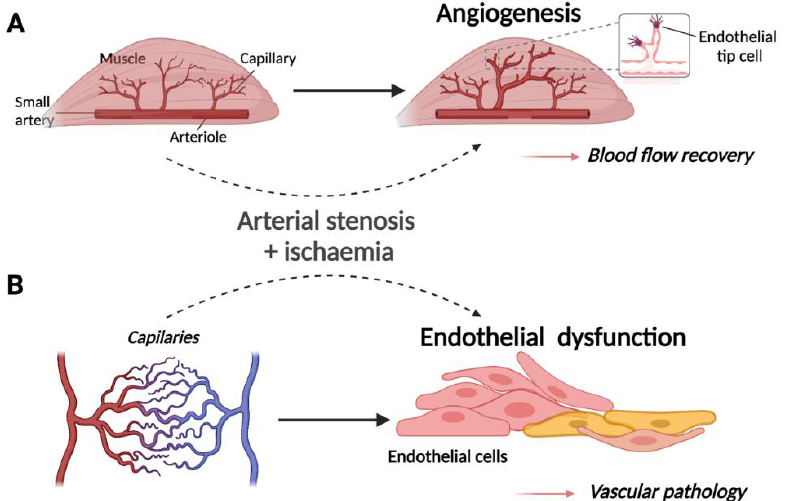
Figure 1. Schematic representation of ( A ) the normal physiological response to ischaemia in muscle tissue and ( B ) the pathogenesis of ischaemic vascular disease in endothelial cells (modified from [7]). Created with BioRender.com. ( A ) Upon restricted blood supply to the musculature, capillary beds within the ischaemic tissue undergo physiological angiogenesis whereby new vessels branch from the arterioles and infiltrate muscle fibres to increase the delivery of oxygen to metabolically active cells. ( B ) Upstream arterial stenosis or occlusion due to atherosclerosis may result in ischaemia of capillary ECs, promoting endothelial dysfunction and contributing to pathogenesis of occlusive arterial disease.